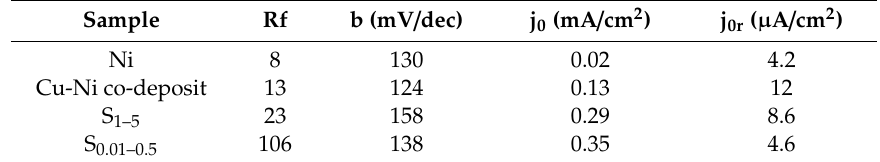
Table 3. Kinetic parameters for HER obtained from the polarization curves recorded in 1 M KOH. Sample Rf b (mV / dec) j 0 (mA / cm 2 ) j 0r ( µ A / cm 2